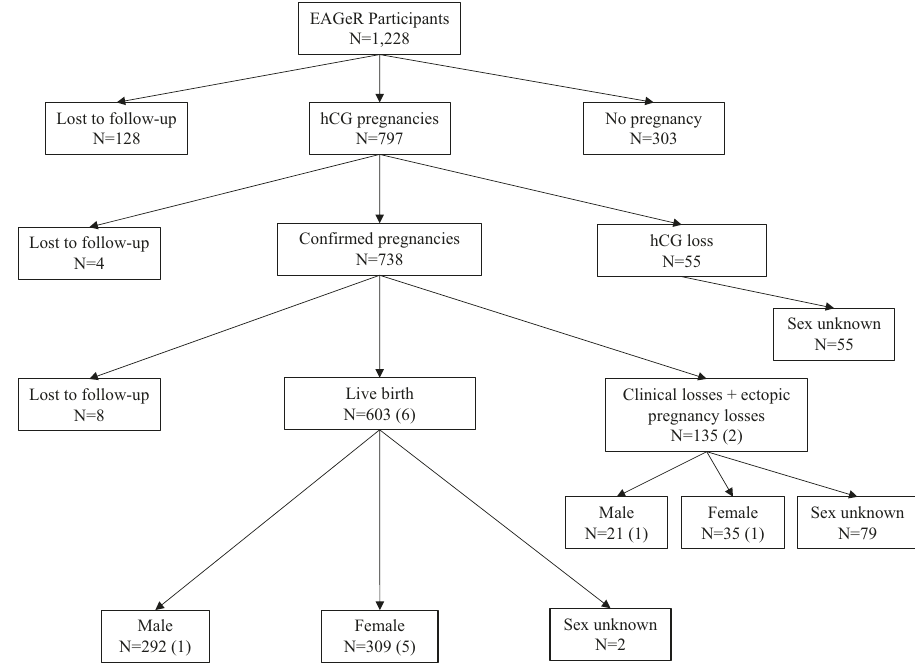
Fig. 2 Flowchart of 1228 Effect of Aspirin in Gestation and Reproduction (EAGeR) trial participants. Twin gestations are indicated in parentheses. The unit of analysis was the mother – offspring pair. 738 “ con fi rmed pregnancies ” include 732 clinical pregnancies + 6 non-viable ectopic pregnancies, which were considered to be clinical pregnancy losses upon ultrasound